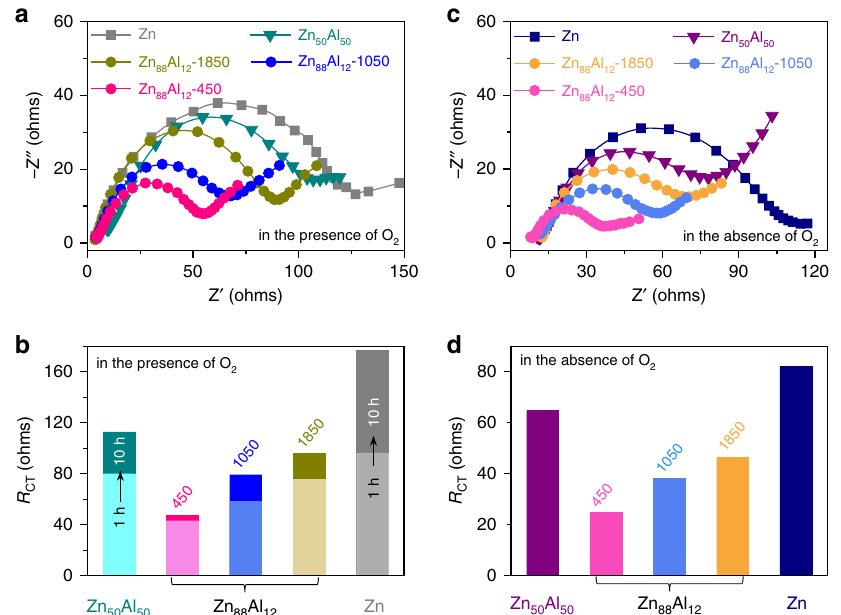
Fig. 3 Oxidation-resistance capability of Zn metal and eutectic Zn/Al alloys. a Electrochemical impedance spectra (EIS) of eutectic Zn 88 Al 12 alloys with various lamellar spacings ( λ = ∼ 450, ∼ 1050 and ∼ 1850 nm), hypoeutectic Zn 50 Al 50 alloy and monometallic Zn after immersed in the O 2 -present ZnSO 4 aqueous electrolytes for 1 h. b Evolutions of the charge transfer resistances ( R CT ) of eutectic Zn 88 Al 12 alloys with various lamellar spacings ( λ = ∼ 450, ∼ 1050 and ∼ 1850 nm), hypoeutectic Zn 50 Al 50 alloy and monometallic Zn when extending the immersing time from 1 to 10 h in the O 2 -present ZnSO 4 aqueous electrolytes. c , d EIS spectra of eutectic Zn 88 Al 12 alloys with various lamellar spacings ( λ = ∼ 450, ∼ 1050 and ∼ 1850 nm), hypoeutectic Zn 50 Al 50 alloy and monometallic Zn ( c ) and their corresponding R CT values ( d ) in the O 2 -absent ZnSO 4 aqueous electrolyte for 1 Zn 88 Al 12 alloy is highly reversible, with the CE of ∼ 100 %, during the cycling test for more than 100 cycles (Supplementary Fig. 12).